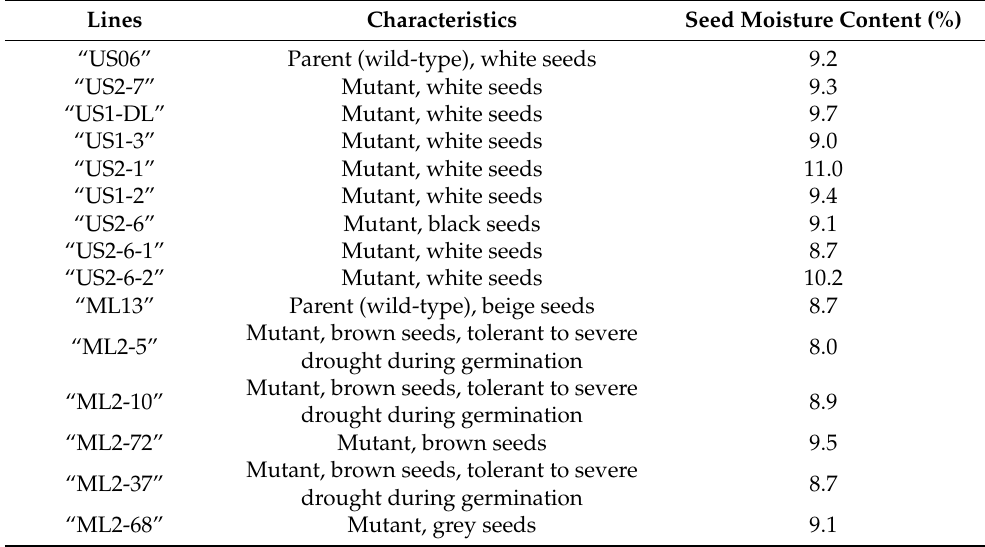
Table 3. Main phenotypic characteristics of the sesame genotypes studied and seeds’ moisture content during